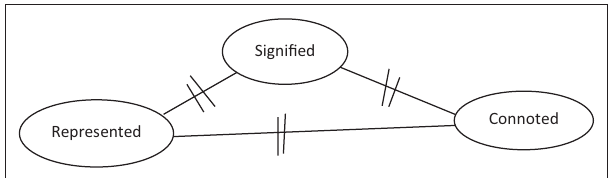
FIGURE 5: The conflict in